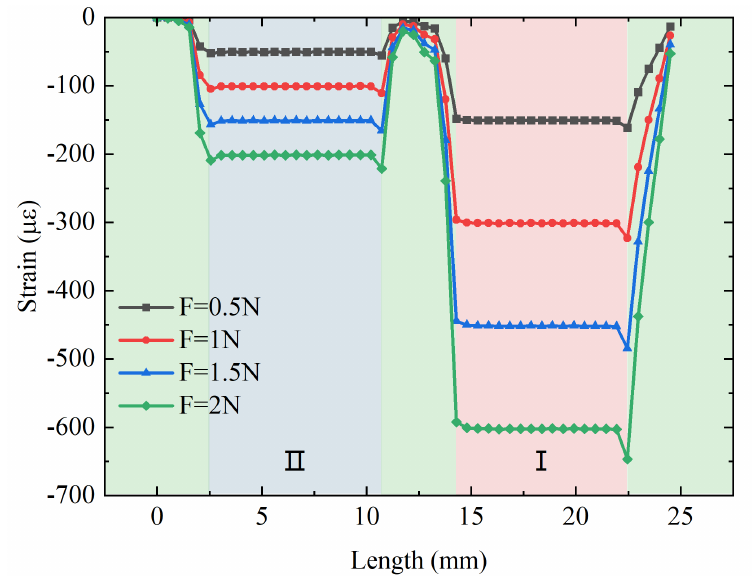
Figure 4. The relation between the applied axial force and the strain distribution along the suspended fiber.